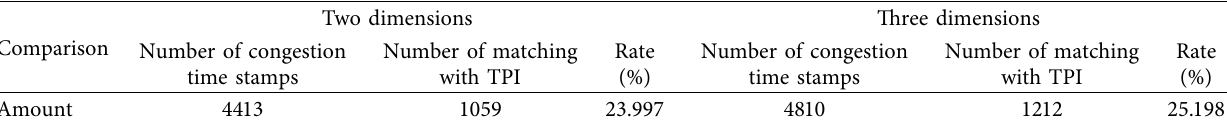
Table 8: Comparison of